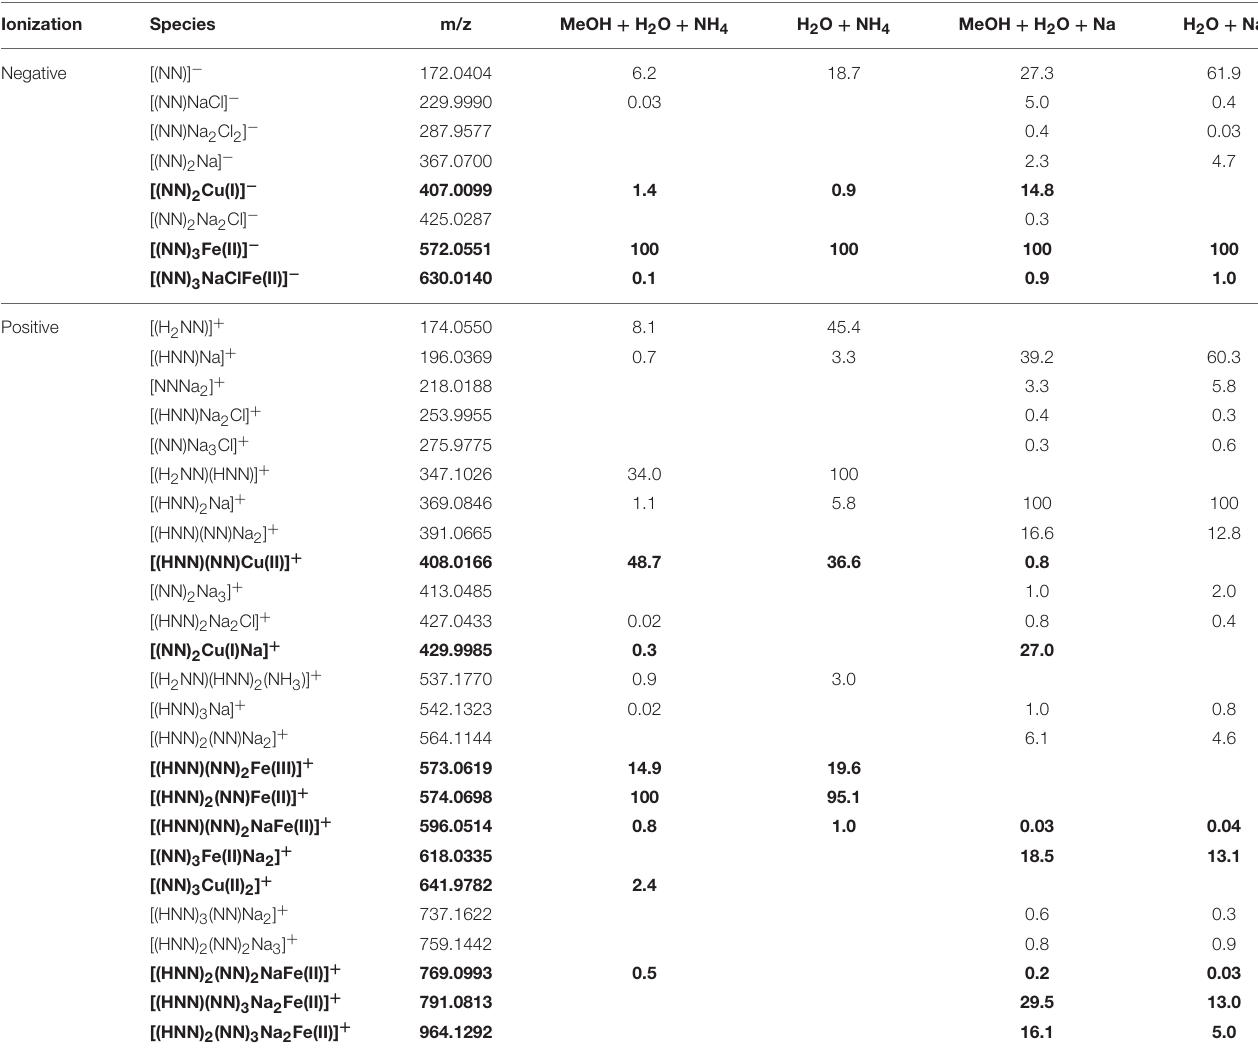
TABLE 4 | Detected NN and NN ± Fe ± Cu species (bold) in the four analytical setups at the FT-ICR-MS. Ionization